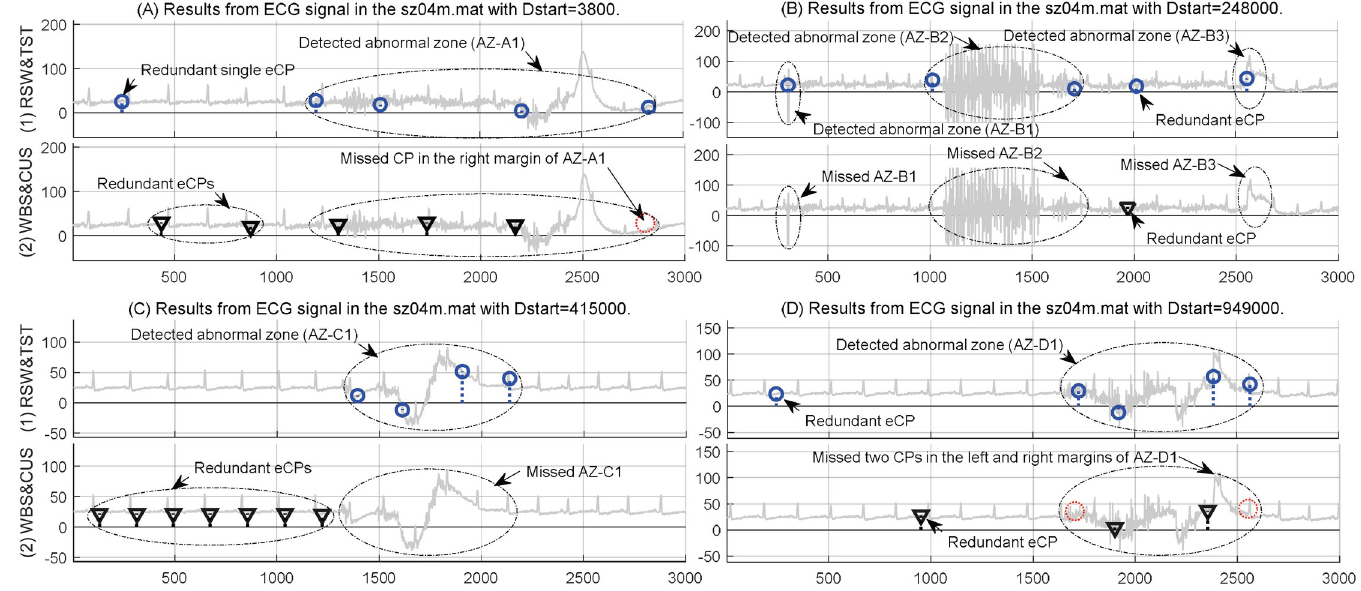
Fig 11. The results of MCPs detection on different ECG segments from sz04m in the partial epilepsy databases. By using the proposed RSW&TST framework and the WBS&CUSUM method, the resultant MCPs were detected from ECG signals in the sz04m.mat with the different start points of (A) Dstart = 3800, (B) Dstart = 24800, (C) Dstart = 415000, and (D) Dstart = 949000, respectively.